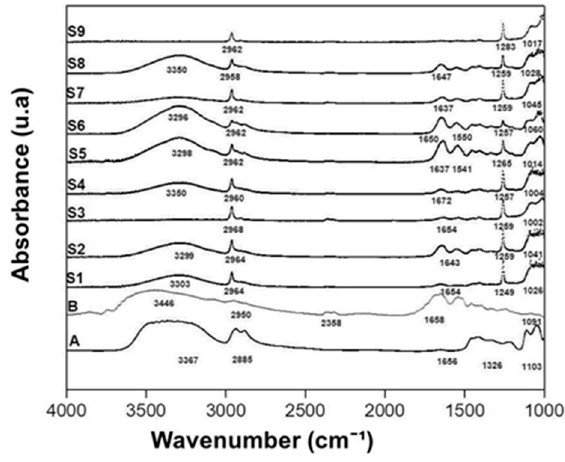
Figure 1. ATR ‐ FTIR for: A: gelatin, B: glycerol and samples S1 to S9. Figure 1. ATR-FTIR for: A: gelatin, B: glycerol and samples S1 to